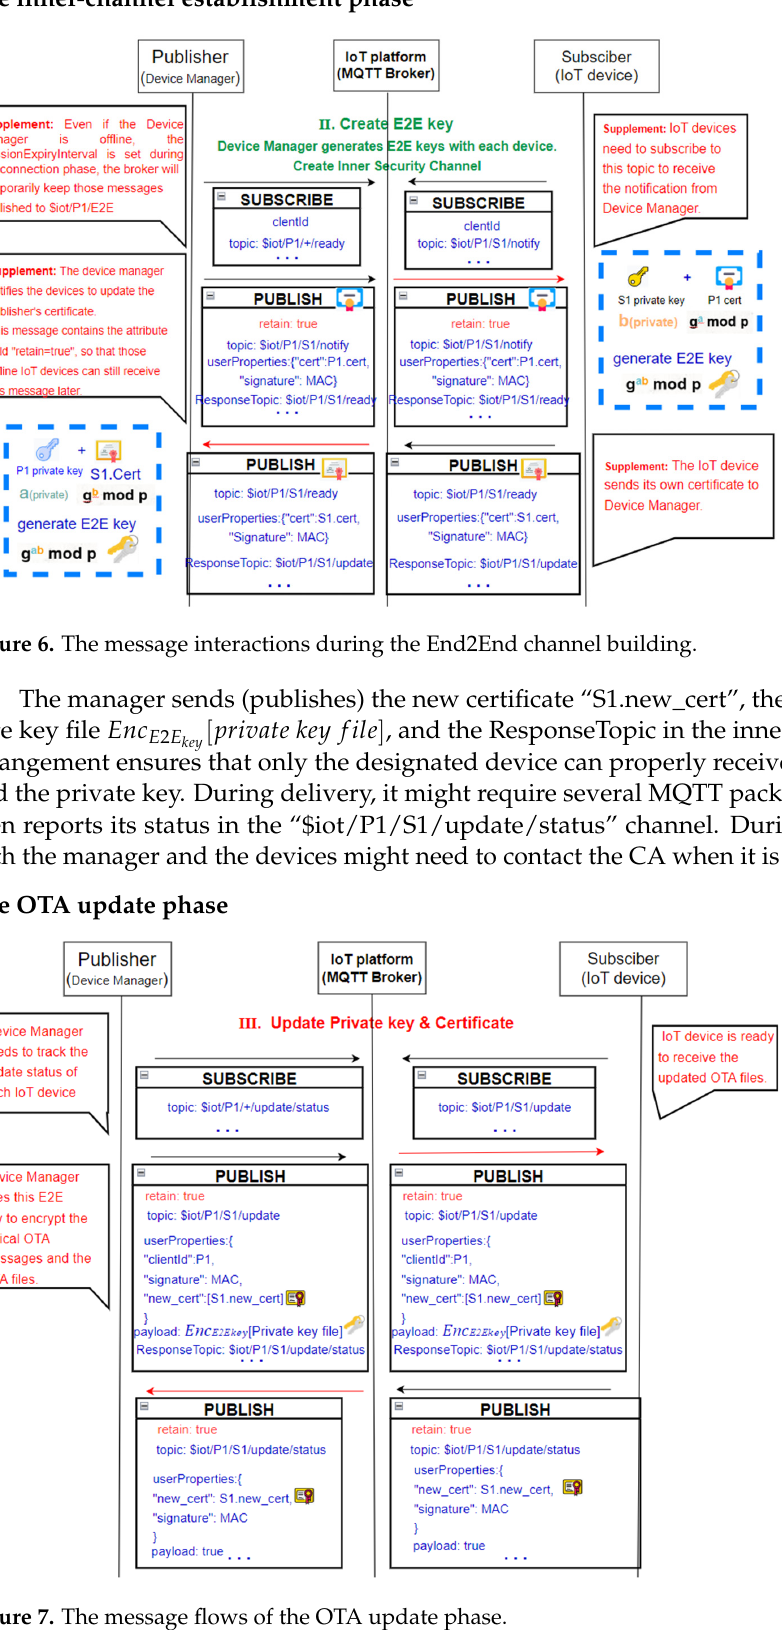
Figure 7. The message flows of the OTA update